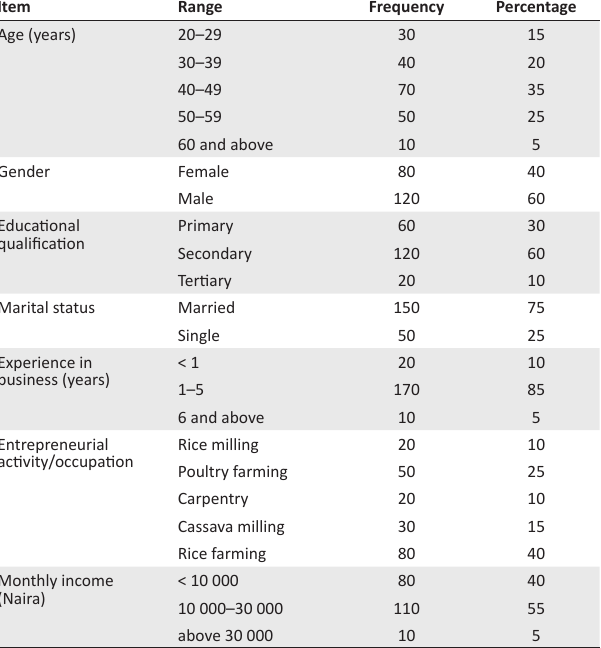
TABLE 1: Socioeconomic profiles of the